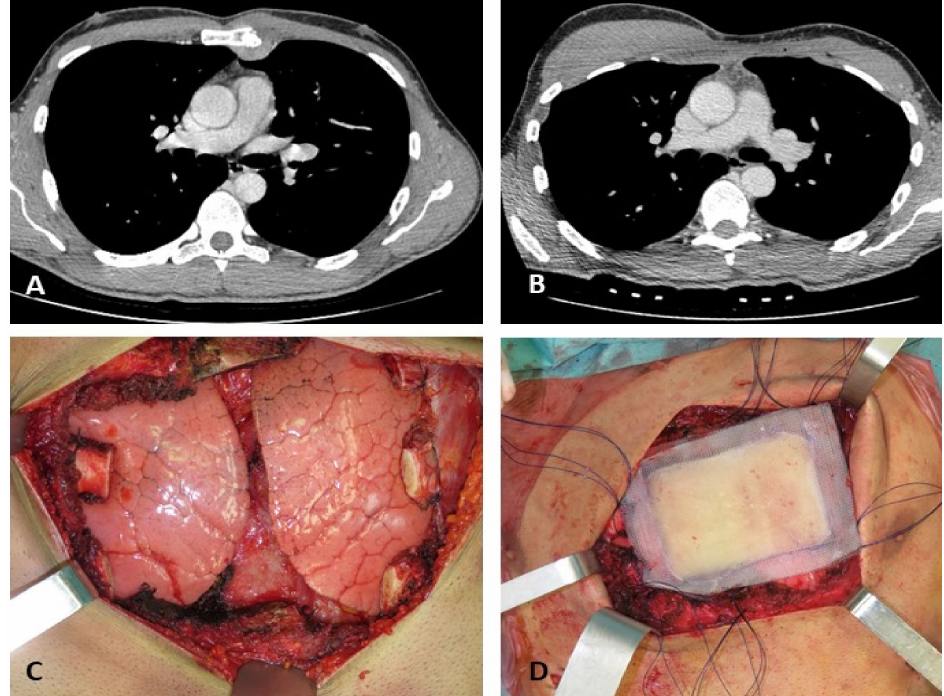
Figure 6. A 35-year-old male patient with a low-grade chondrosarcoma of the sternum. Chondrosar- coma of the sternum with pre- and post-radical resection axial contrast-enhanced CT images ( A , B ). Intraoperative views ( C , D ) show radical resection and reconstruction by composite rigid prosthesis. Courtesy of Prof Francesco Petrella, Istituto Europeo di Oncologia (IEO), Milan,